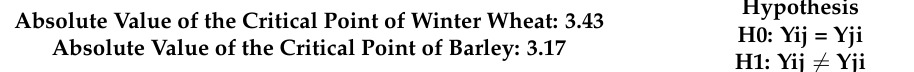
Table 10. F-test results of field data and model for winter wheat and barley